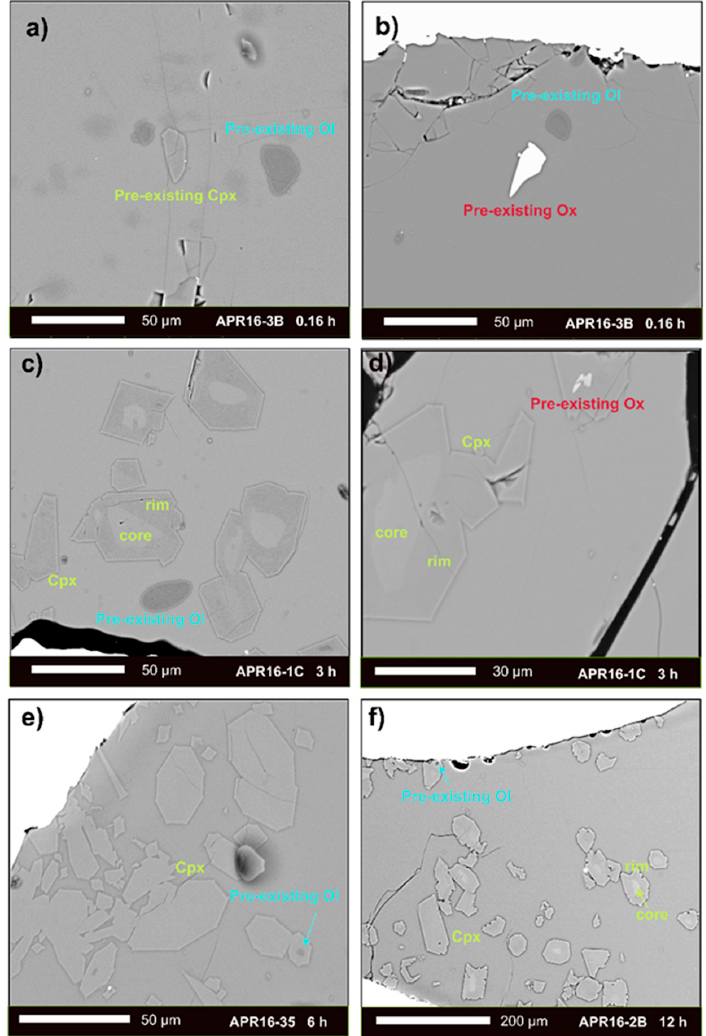
Figure 1. Backscattered SEM image of natural starting material runs: ( a , b ) APR16 ‐ 3B run (0.16 h)